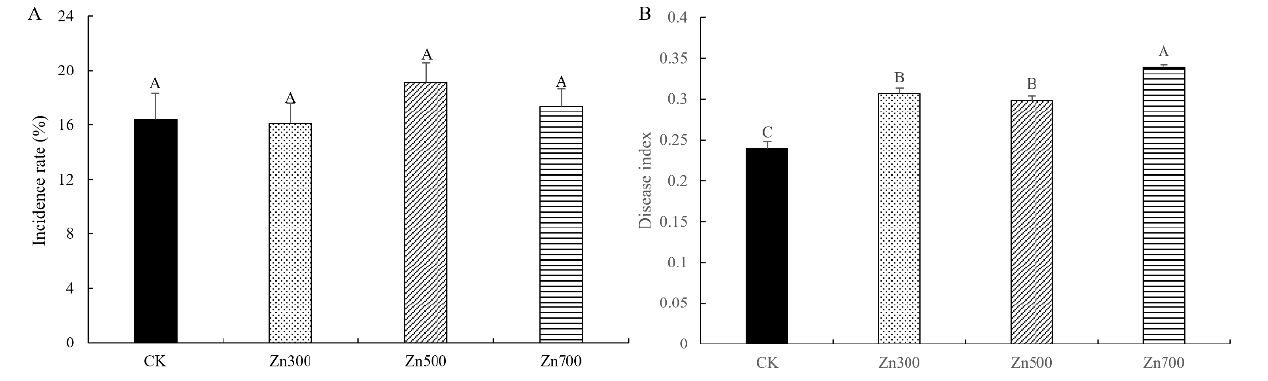
Figure 4. Effects of Zn treatment on the incidence rate ( A ) and disease index ( B ) of rust in P. simonii . The values shown in the figure are the average value ± SD (n = 3). Different letters indicate that there are significant differences among groups (one-way ANOVA, p < 0.05). Table 3. Correlation analysis between pathogenesis parameters of leaf rust and Zn content or chemical defense